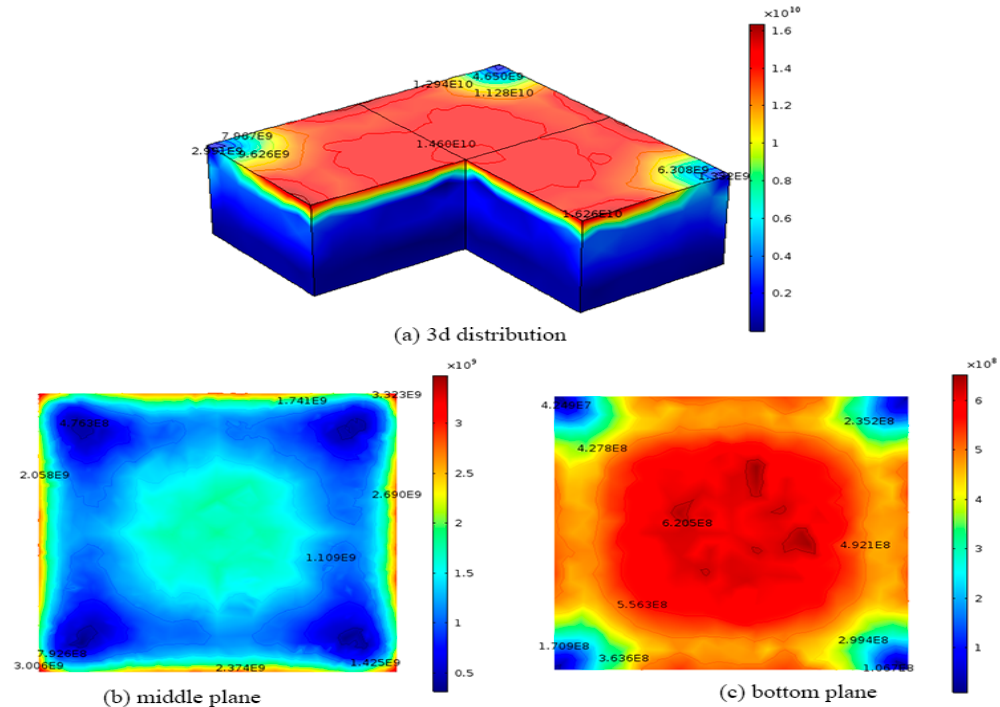
Figure 7. Dislocation density distributions of 0.84 m × 0.84 m × 0.3 m ingot at the end of the cooling process obtained from the CRSS model with the modified cooling process ( a ) 3D distribution; ( b ) middle plane; ( c ) bottom plane.